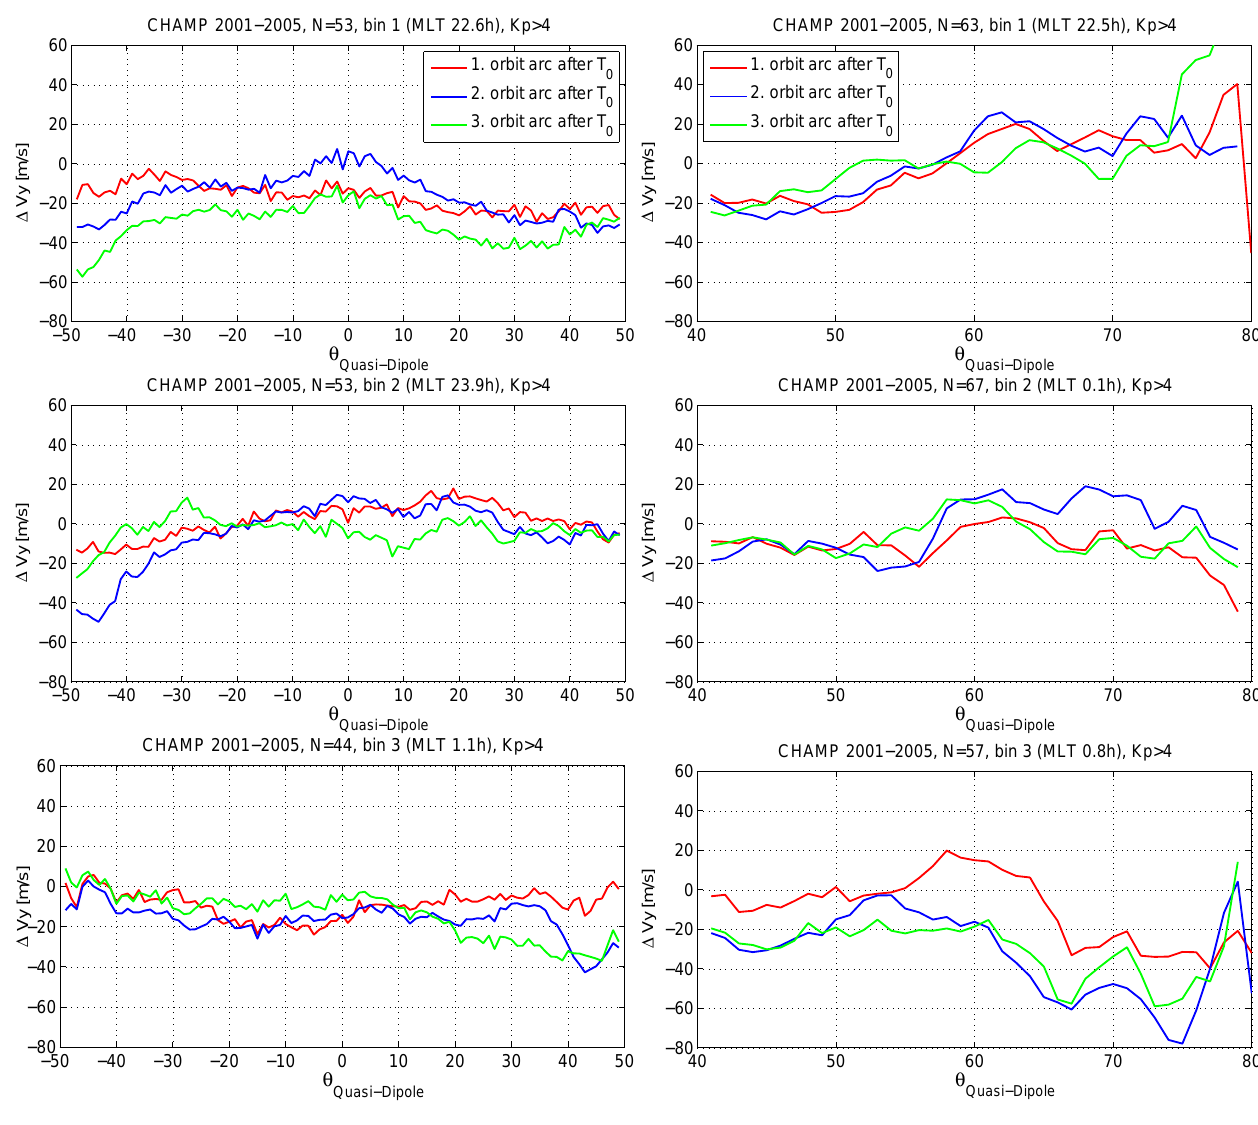
Fig. 9. Differences of zonal wind velocity, data before a substorm onset are subtracted from data after T 0 , at low (left column) and high (right column) latitudes for Kp > 4. Frames from top to bottom contain subsets of bins 1,2,3 with calculated mean MLT 22.5h, 24.0h, 1.0h, respectively. Red line: 0.25–1.25h after substorm onset T 0 ; blue line: 1.75–2.75h after T 0 ; green line: 3.25–4.25h after T 0 . The mean uncertainty of the zonal wind curves is ±